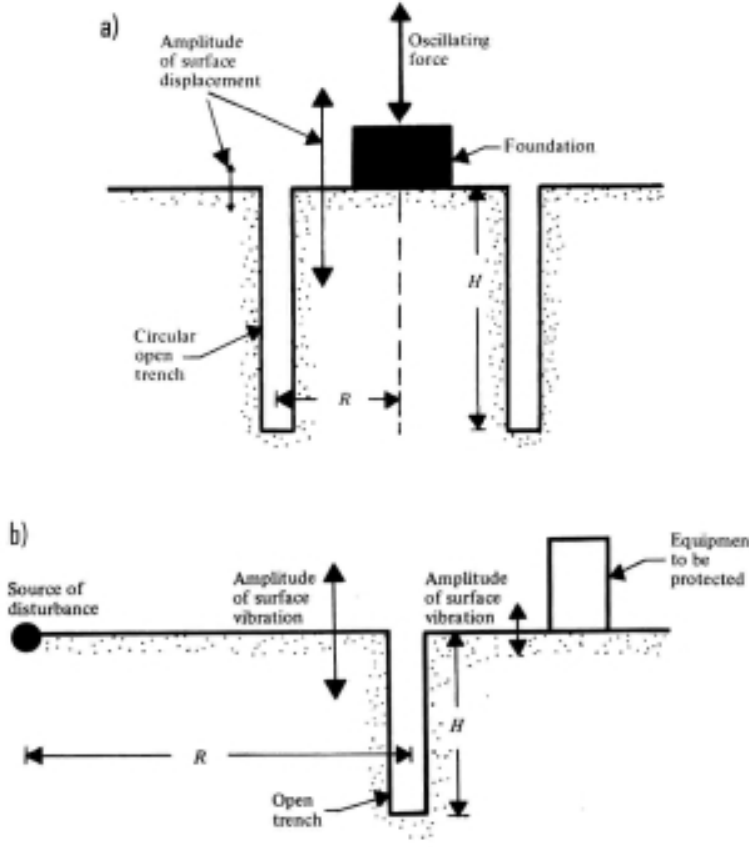
Fig. 1. Active and passive isolation by adequately using (a) a circular open trench, and (b) segment open trench